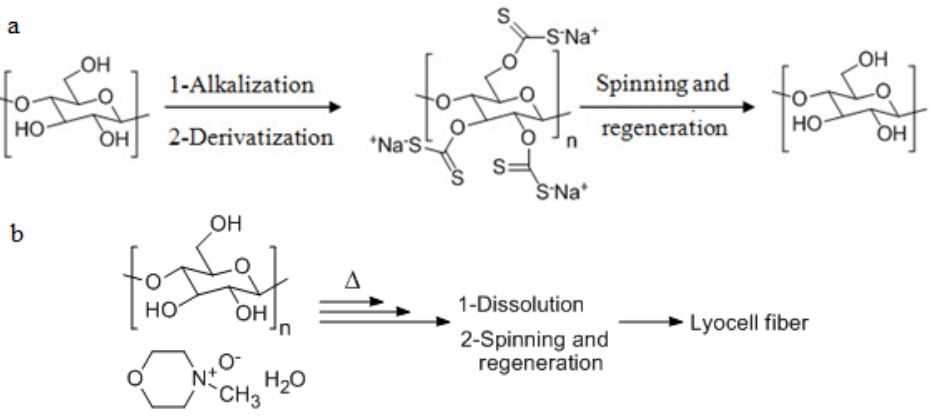
Figure 1. Chemical representation of two industrially important cellulose technologies ( a ) Viscose and ( b ) Lyocell processes. Δ = heat provided to the